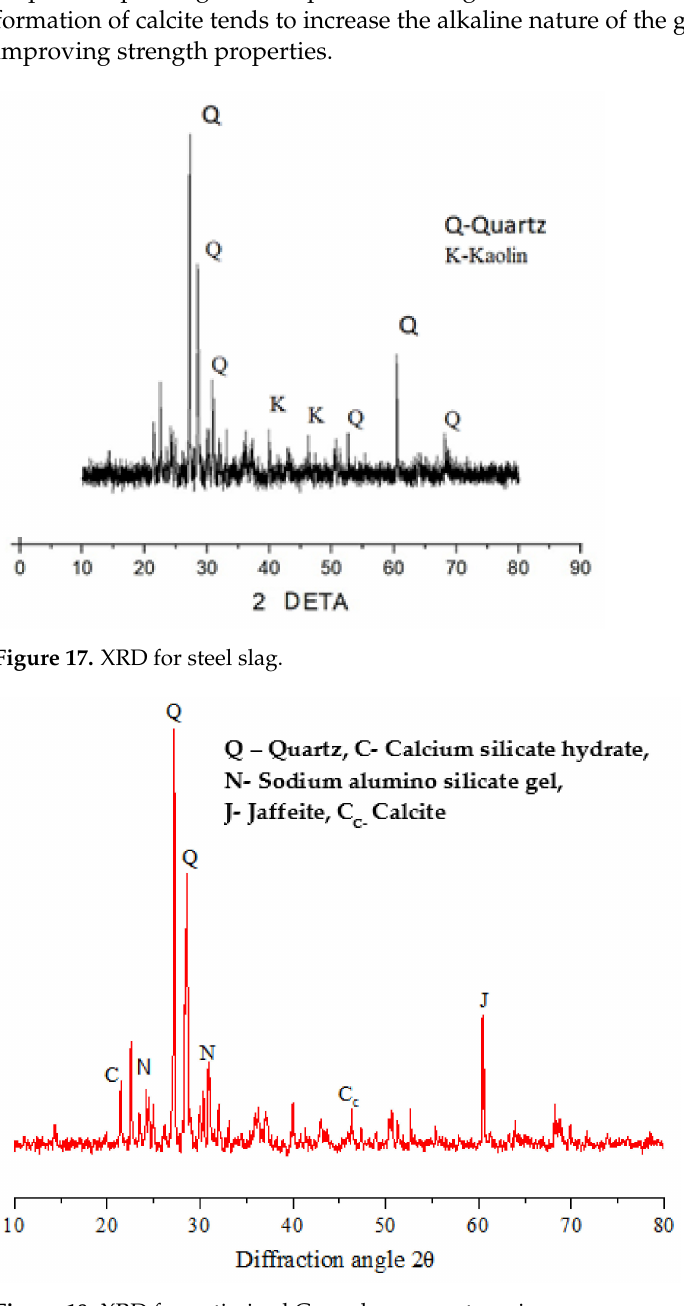
Figure 18. XRD for optimized Geopolymer mortar